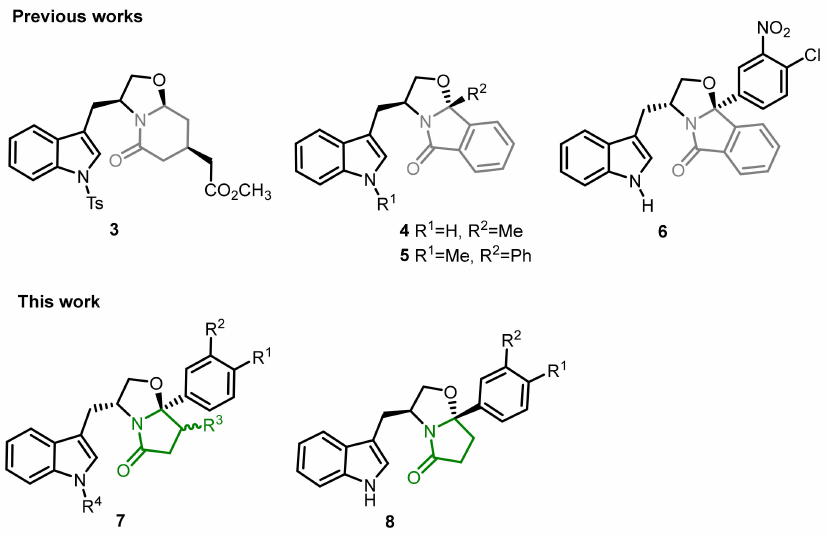
Figure 2. Previously reported tryptophanol-based scaffolds 3 – 6 and tryptophanol-derived oxazolopy- rrolidones 7 – 8 studied in this